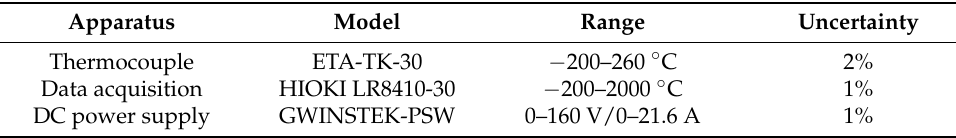
Table 2. Uncertainty analysis of experimental